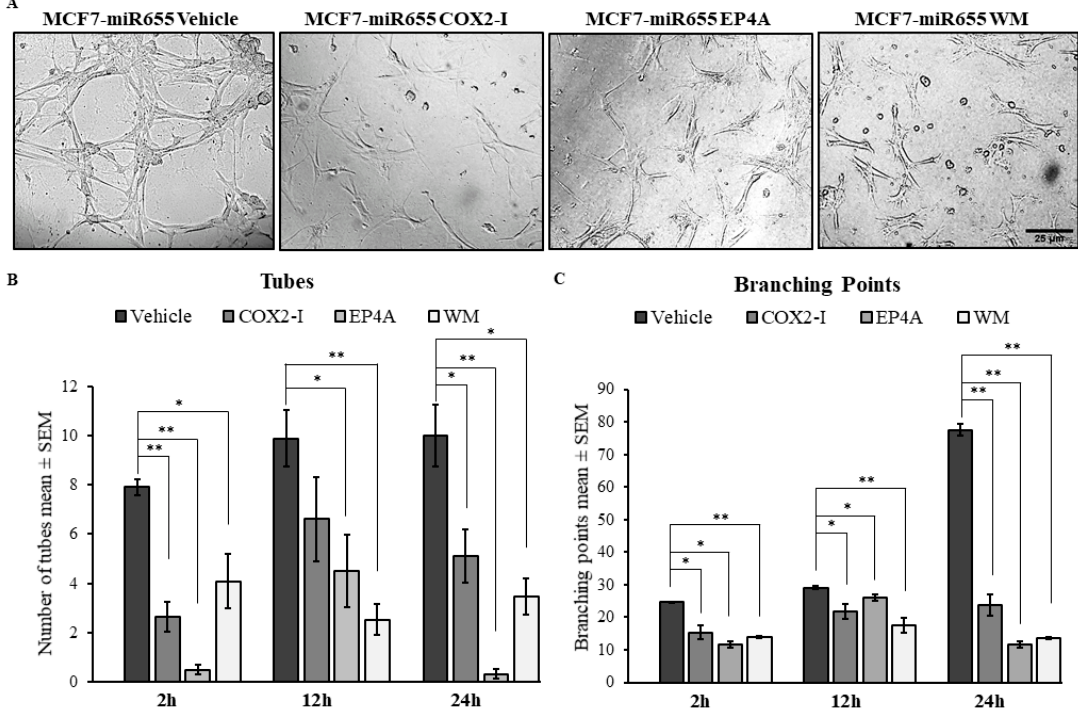
Figure 5. Treatment with COX2-I, EP4A, or PI3K pathway inhibitor (Wortmannin, WM) abrogates the tube formation stimulation abilities of MCF7-miR655 conditioned media. ( A ) Images of all treatments; miRNA-conditioned media with vehicle, COX2-I, EP4A , or PI3K inhibitor (WM) conditions at the 24 h time point. ( B ) Quantitative analysis of number of tubes formed per time point, per condition. ( C ) Quantitative analysis of branching points per time point, per condition. Quantitative data presented as the mean ± SEM of three biological replicates, including three experimental replicates per biological replicate; * p < 0.05, ** p < 0.01.